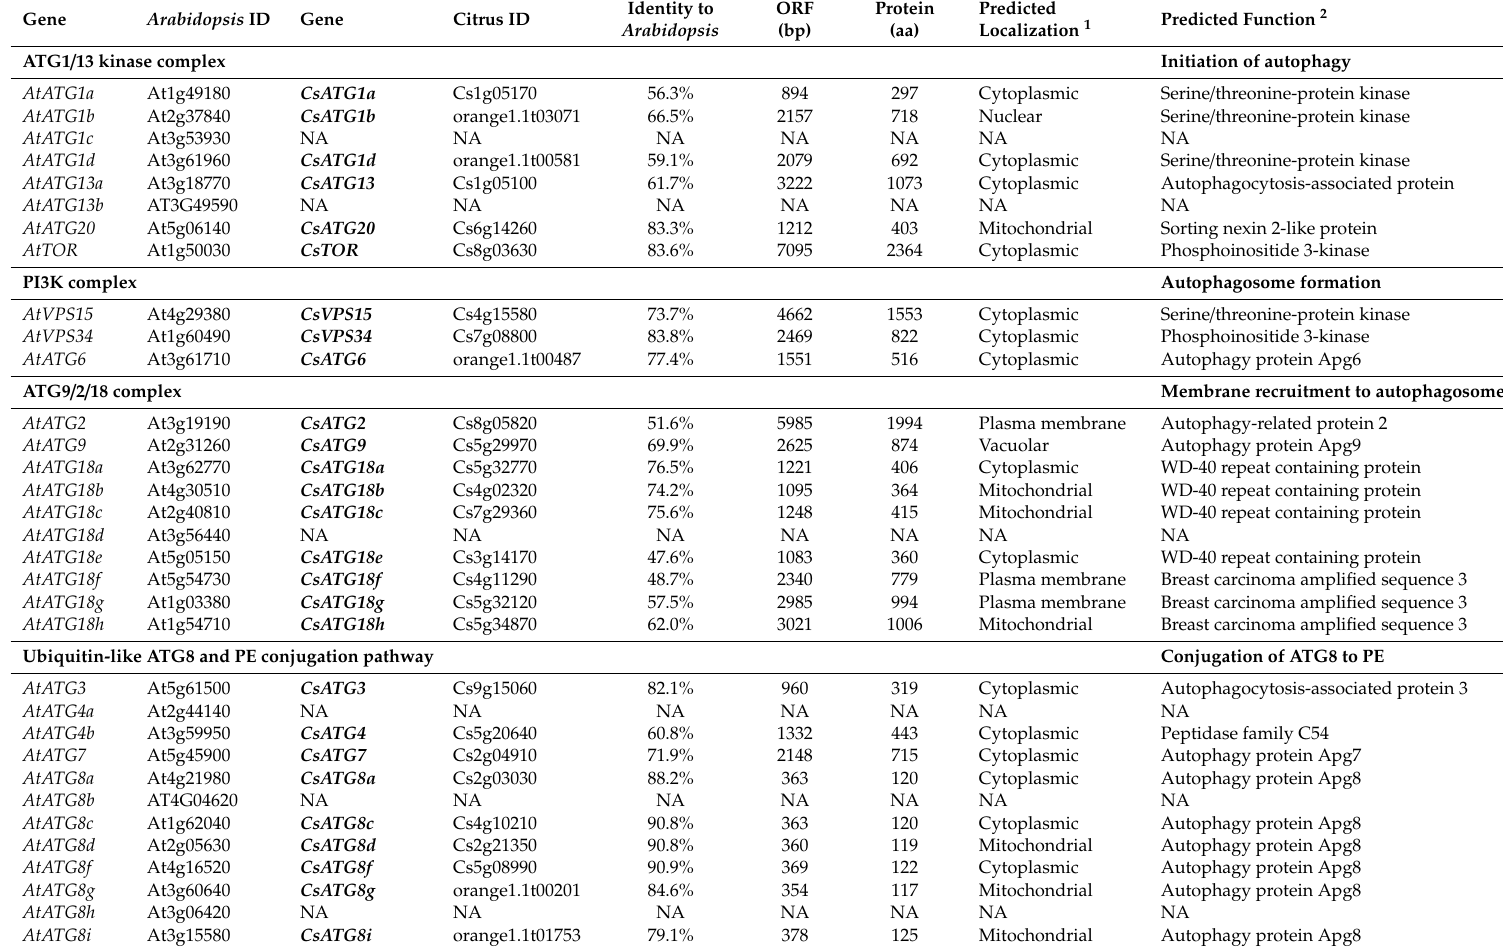
Table 1. Detailed information of autophagy-related genes (ATGs) in Arabidopsis and sweet